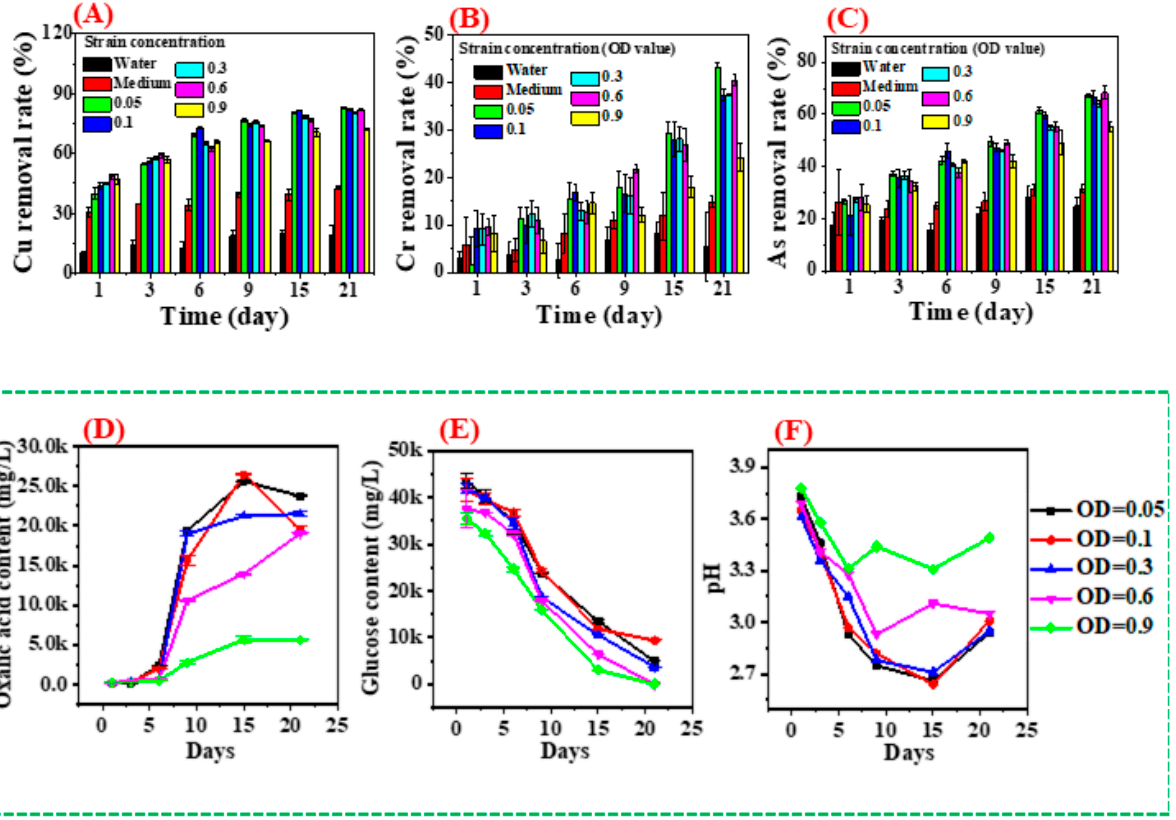
Figure 5. Removal rates of Cu ( A ), Cr ( B ), and As ( C ) from CCA-treated wood using Y. lipolytica , and the amounts of oxalic acid ( D ) and glucose ( E ) in the fermentation medium, the pH value of the fermentation medium ( F ).